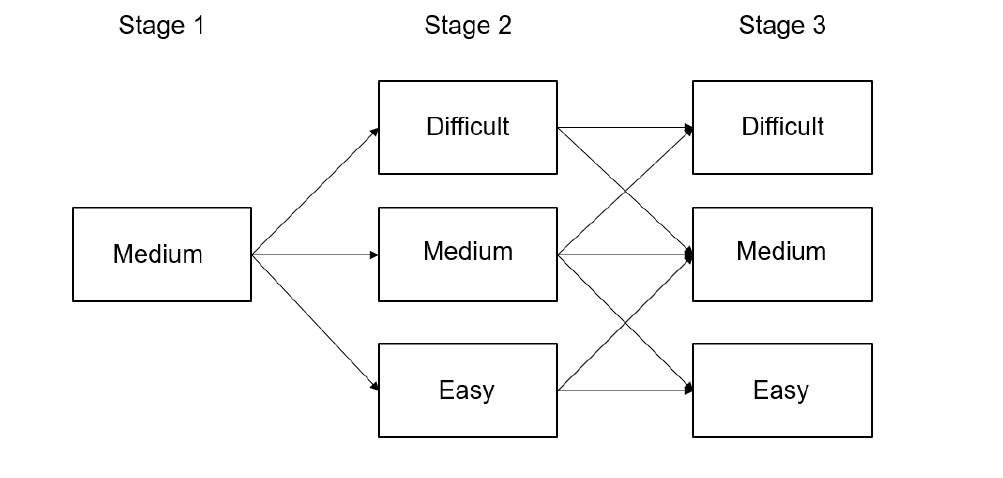
Figure 1. The paths through the simulated multistage